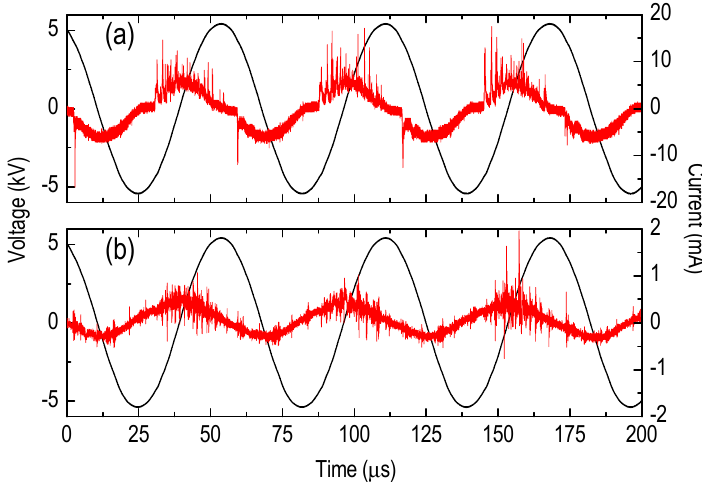
Figure 2. Representative discharge waveforms in absence of liquid target. ( a ) Voltage (black) and DBD current (red). ( b ) Voltage (black) and Jet current (red). Operating conditions: 11 kV pp , 17.5 kHz, and 1.5 slm.